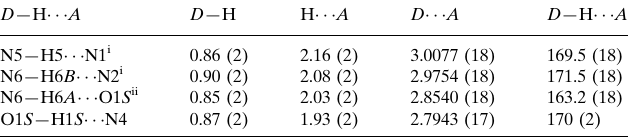
Hydrogen-bond geometry (A˚ , (cid:3)